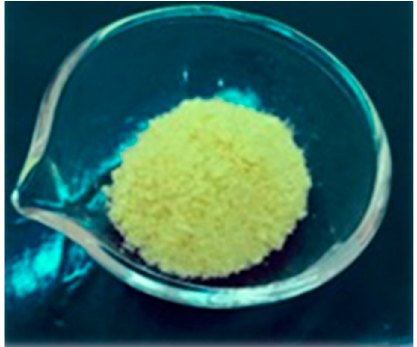
Figure 3. Appearance of the freeze-dried BioQ-CPX nanocomposite powder.